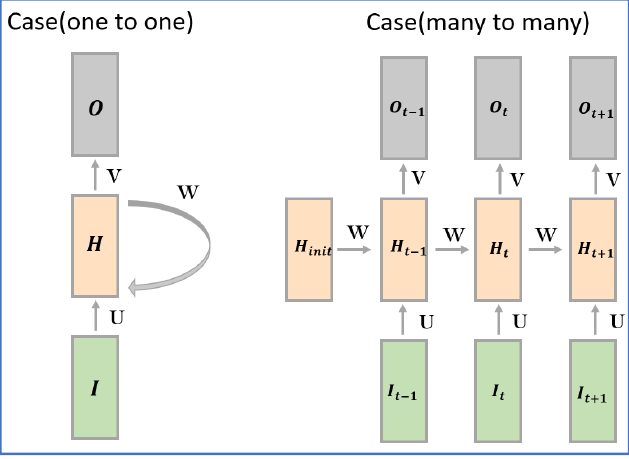
Figure 2. RNN (Recurrent Neural Network) algorithm.